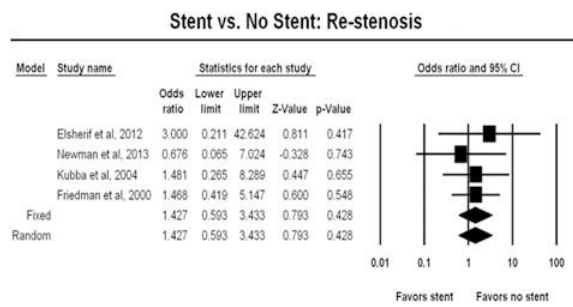
Forest plot for meta-analysis of studies comparing stent insertion versus no stent insertion as regards the incidence of restenosis. CI, confidence